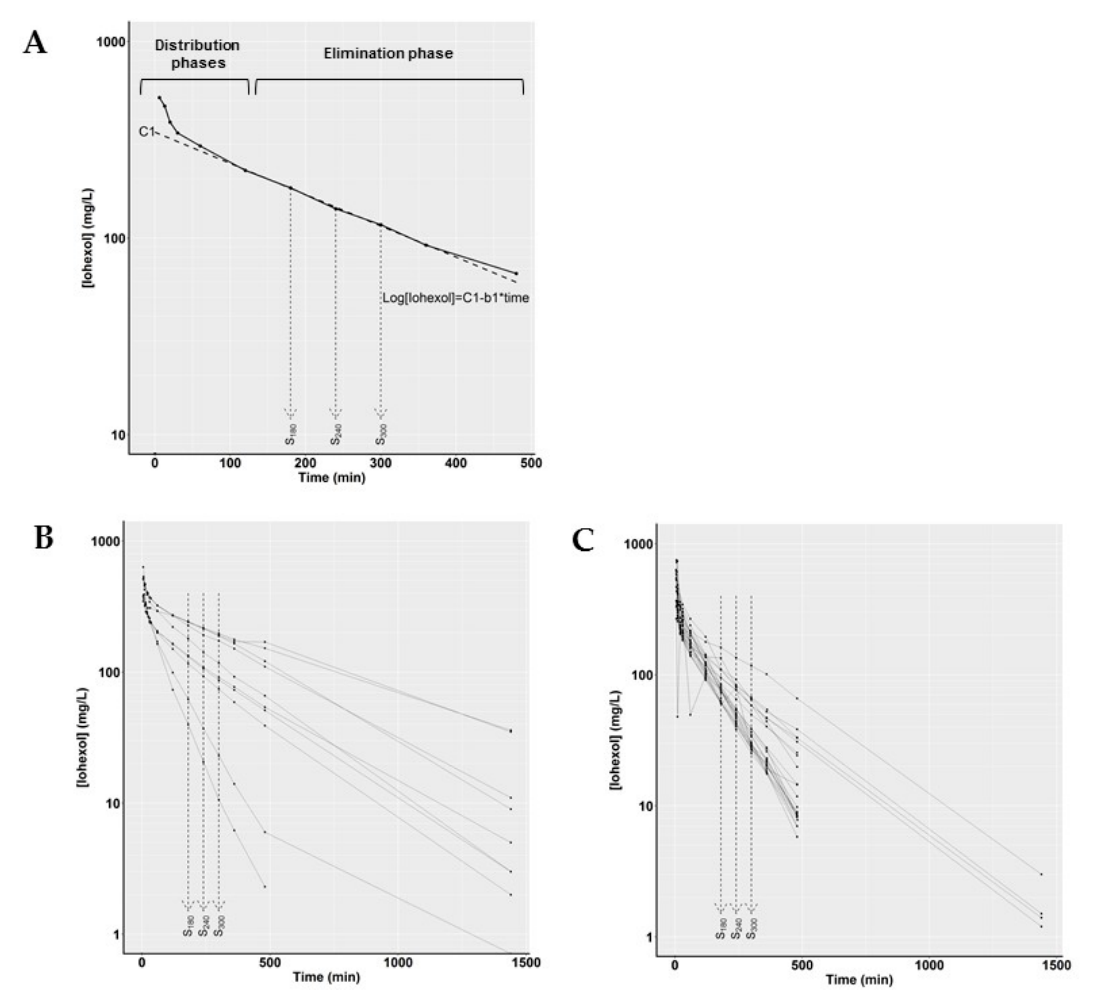
Figure 1. ( A ) Example of a typical plasma concentration–time profile after bolus administration of iohexol in a uremic goat ( n = 1). Solid circles represent the iohexol plasma concentrations, the dotted line represents the linear regression (intercept; C 1 , slope; b 1 ) over the log-transformed iohexol plasma concentrations taken at sample times 180, 240 and 300 min (S 180 , S 240 and S 300 , respectively). ( B , C ) Plasma concentration–time profiles of all iohexol plasma clearance measurements after bolus administration of iohexol in goats ( B ) and pigs ( C ). Circles represent the iohexol plasma concentrations, the dotted lines represent the iohexol plasma concentrations taken at S 180 , S 240 and S 300 , which were used for linear regression analysis according to the simplified